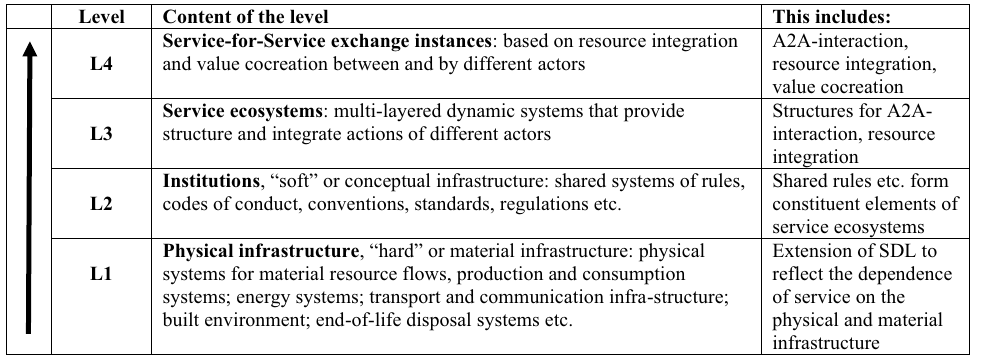
Table 1. Extended model of